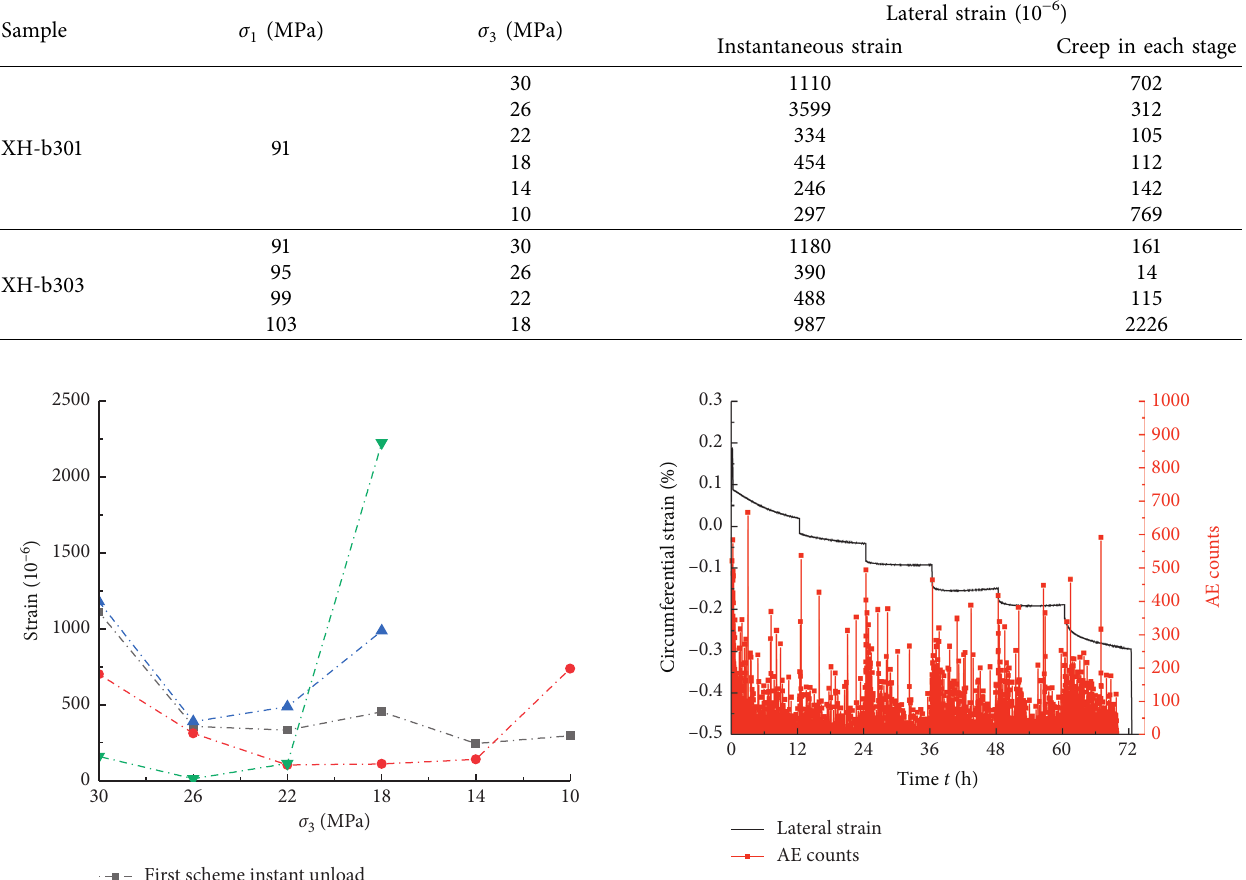
Figure 8: Lateral strain-time-AE count curve of constant axial pressure grade unloading confining pressure.